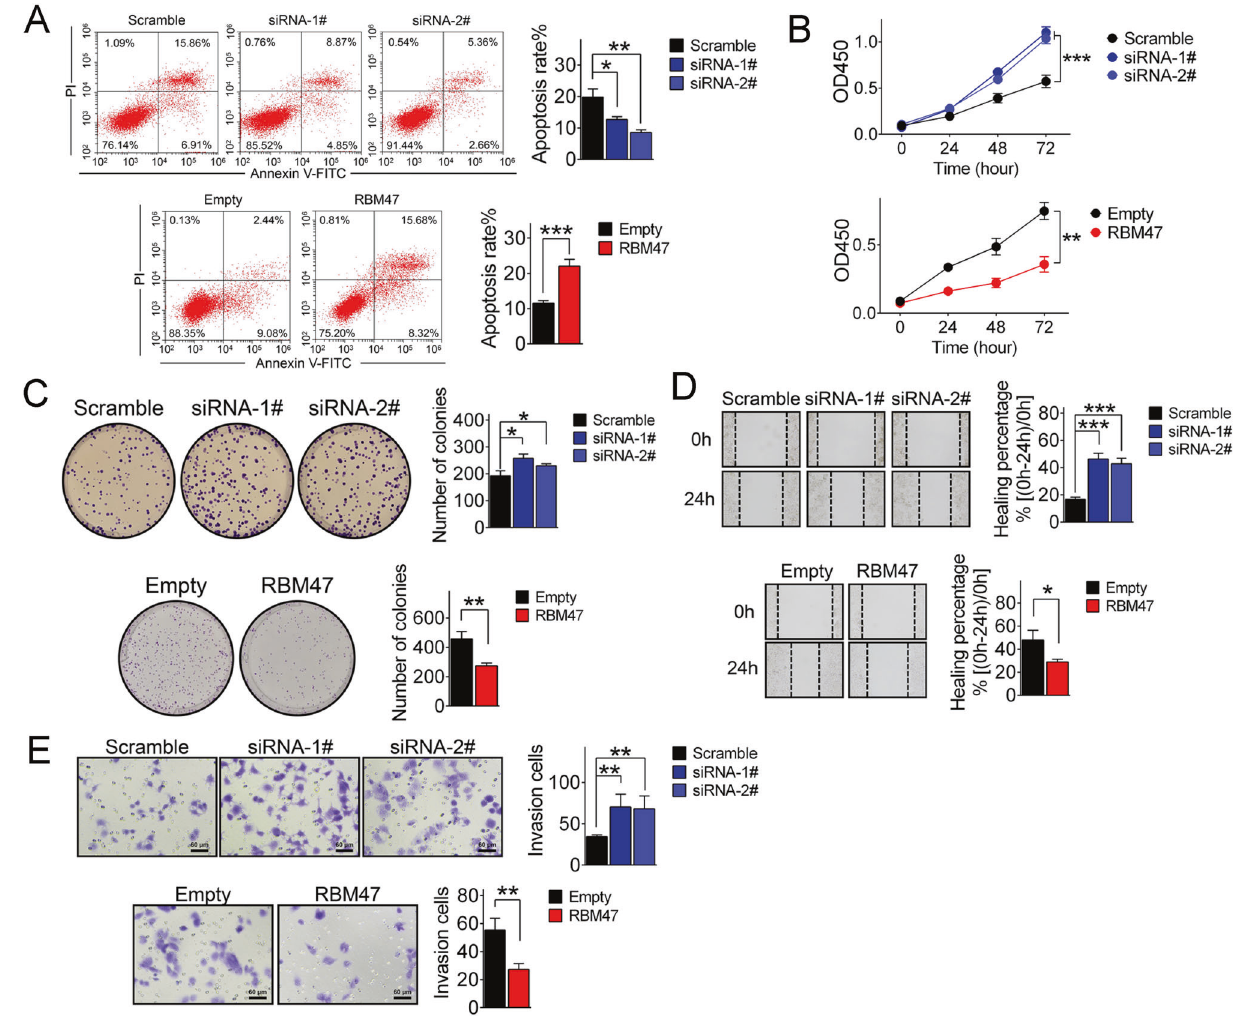
Fig. 1 RBM47 inhibits oncogenic behaviors in vitro. A Flow cytometric analysis determined that RBM47 could signi fi cantly promote apoptosis in Huh7 (upper panel) and HCCLM3 (lower panel) cells. Error bars are SD ( n = 3). B Proliferation of Huh7 (upper panel) and HCCLM3 (lower panel) cells was tested by CCK-8 assay after RBM47 knockdown and overexpression, respectively. Error bars are SD ( n = 3). C Colony formation was enhanced when RBM47 expression was decreased (upper panel) and suppressed when RBM47 expression was enhanced (lower panel) in Huh7 and HCCLM3 cells. Error bars are SD ( n = 3). D Representative images of wound healing assays performed after RBM47 silencing in Huh7 cells (upper panel) and enforced overexpression in HCCLM3 cells (lower panel). Error bars are SD ( n = 3). E Transwell assays performed using Huh7 cells after RBM47 knockdown and HCCLM3 cells after RBM47 overexpression (bar = 60 μ m). Error bars are SD ( n = 3). * P < 0.05, ** P < 0.01, *** P <